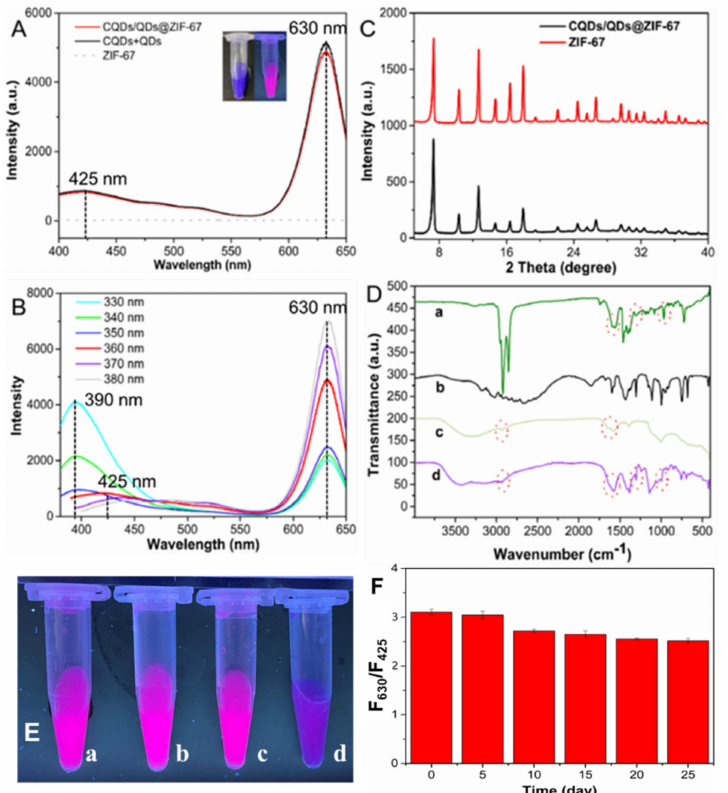
Figure 2. ( A ) Fluorescence emission spectra of the mixture of CQDs (2.2 µ g mL − L ) and QDs (7.8 µ g mL − L ), CQDs/QDs@ZIF-67 (250 µ g mL − 1 ). The inset is the photographs of water dispersions of CQDs/QDs@ZIF-67 under daylight (a) and UV light (b); ( B ) fluorescence emission spectra of CQDs/QDs@ZIF-67 solutions upon various fluorescence excitation wavelengths; ( C ) PXRD patterns of QDs/CDs@ZIF-67 composite and pure ZIF-67; ( D ) FT-IR spectra of QDs (a), pure ZIF-67(b), CQDs (c) and CQDs/QDs @ZIF-67 (d). ( E ) Images of the composite of CQDs/QDs@ZIF-67 (a) and the mixture of CQDs/QDs and ZIF-67 (b) before rinse; the composite of CQDs/QDs@ZIF-67 (c) and the mixture of CQDs/QDs and ZIF-67 (d) after 5 rinse; ( F ) Long-term stability of CQDs/QDs@ZIF-67.